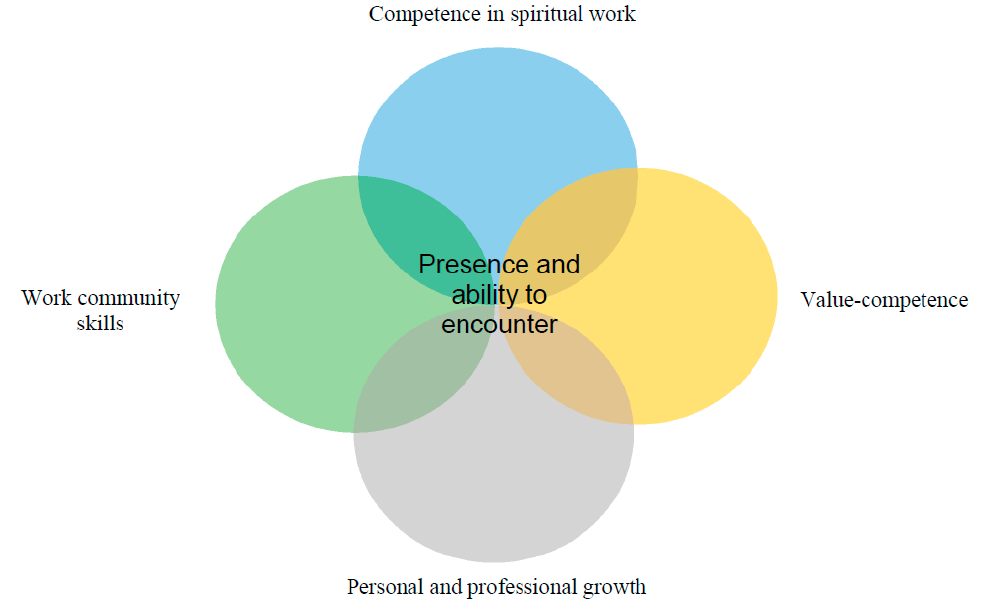
Figure 1. The core competencies in the ecclesiastical professions. 26